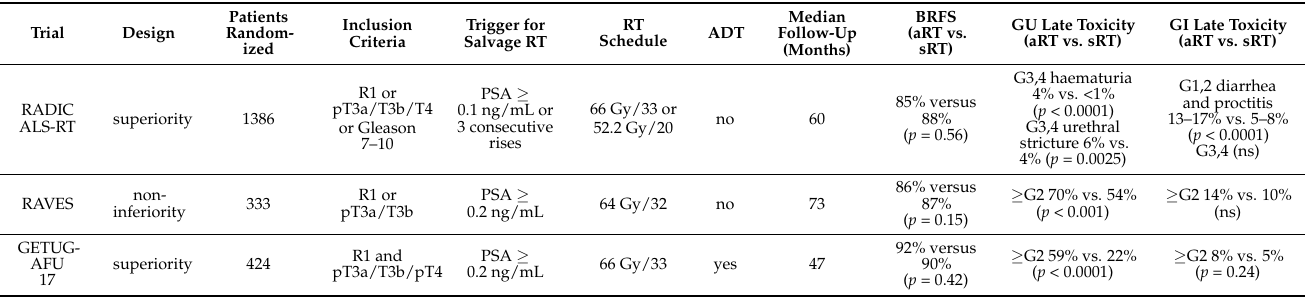
Table 2. Randomized trials comparing salvage and adjuvant